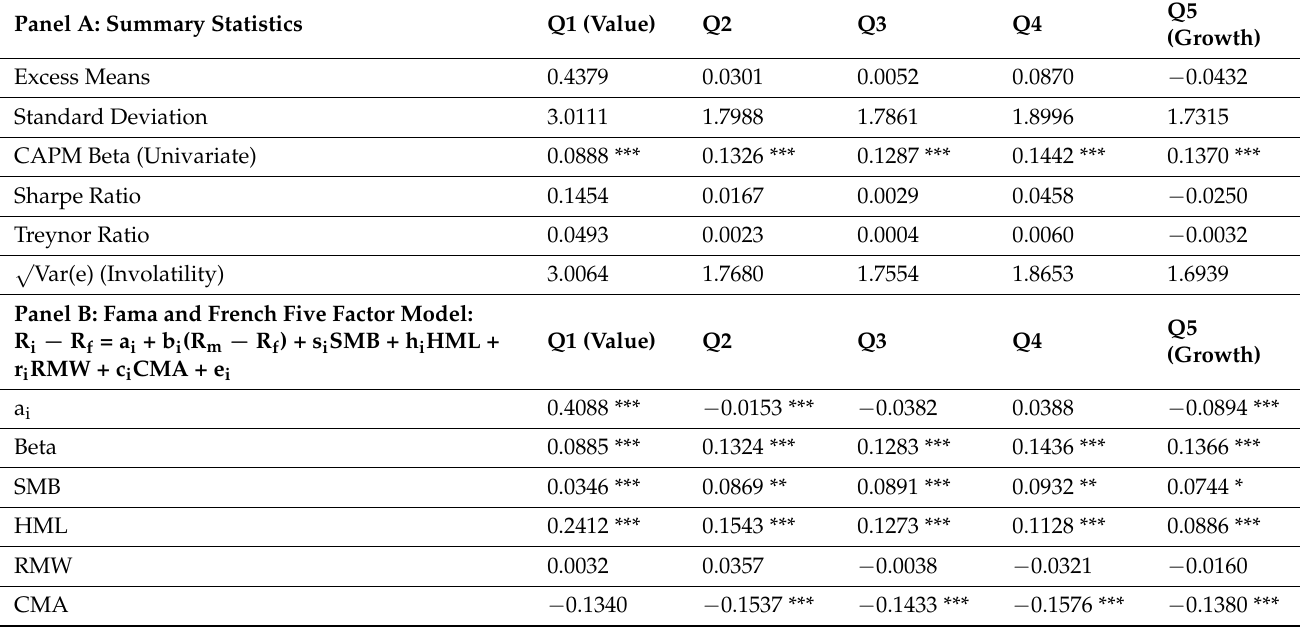
Table 3. Risk measures for Value and Growth REIT portfolios